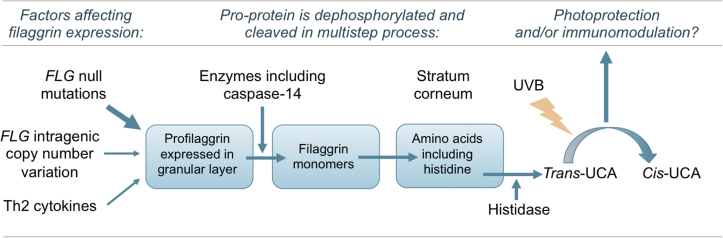
Diagrammatic summary of factors affecting the profilaggrin–cis-UCA pathwayPrevious studies have demonstrated the effects of variation within FLGE6, E7, E8 and levels of TH2 cytokinesE10, E9 on filaggrin expression. The role of caspase-14 in profilaggrin processing has been illustrated in mice.E11 Filaggrin is degraded to release a pool of amino acids rich in histidineE12 in the stratum corneum, contributing to barrier function through hydration and acidification.E13 The conversion of histidine to trans-UCA is catalyzed by histidase,E14 and the trans-isomer is converted to cis-UCA by UVB.E15 UVB absorption might contribute to cutaneous photoprotection, and cis-UCA might have additional immunomodulatory effects.E16, E17, E18, E19, E20